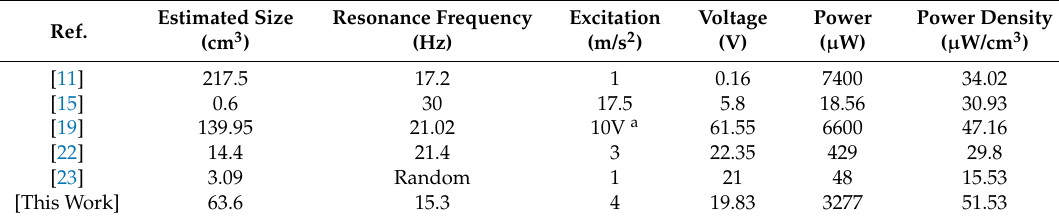
Table 4. Comparisons with reported devices.